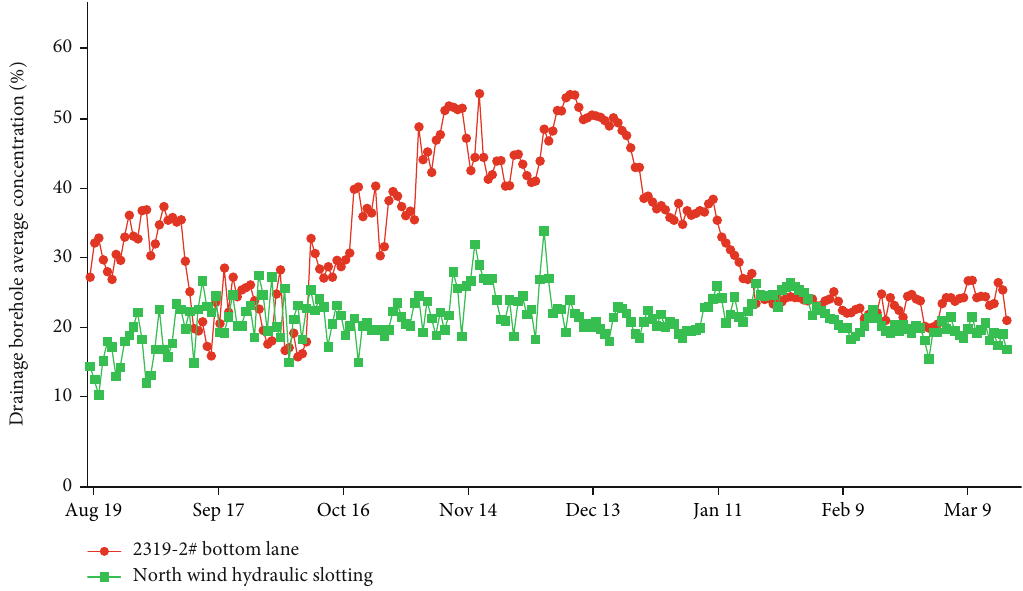
Figure 21: The variation curve of the extraction concentration of the slotted hole and the contrast